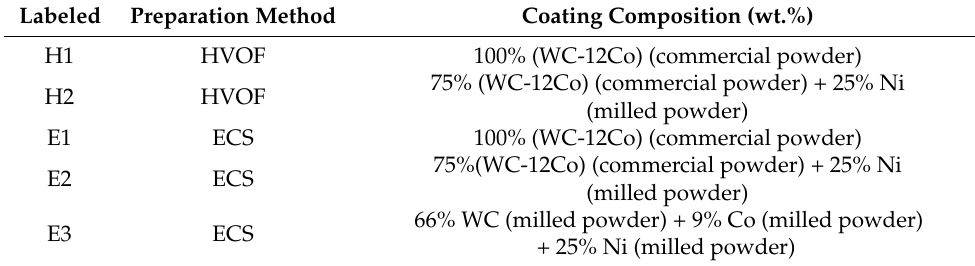
Table 1. Preparation method and raw composition.